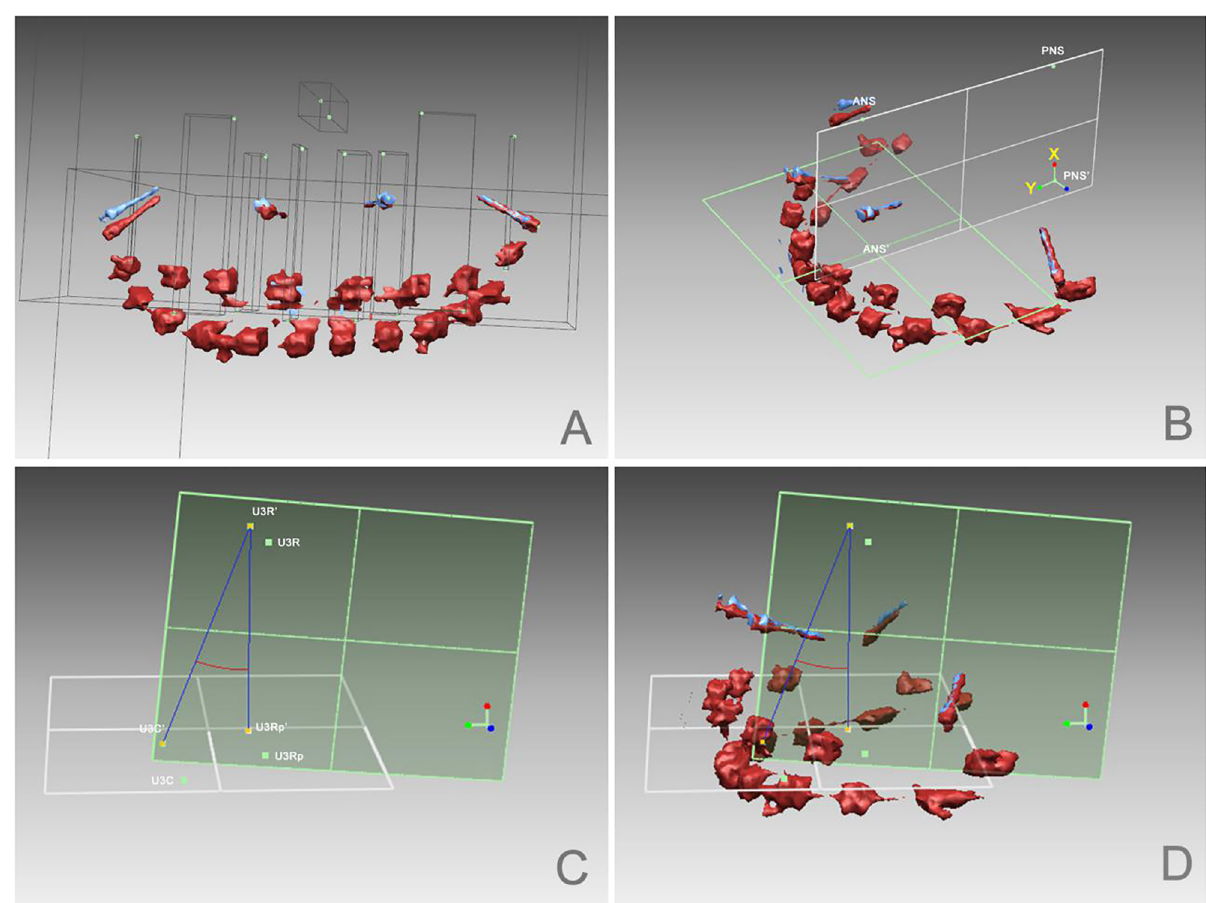
Fig 4. Analysis of 3D STL models performed using the Rapidform software. A. Landmarks were defined as follows: U6C, mesiobuccal crown cusp of the maxillary first molar; U6R, mesiobuccal root tip of the maxillary first molar; U3C, crown cusp of the maxillary canine; U3R, root tip of the maxillary canine; U2C, midpoint of the lateral incisor edge; U2R, root tip of the maxillary lateral incisor; U1C, midpoint of the central incisor edge; U1R, root tip of the maxillary central incisor; ANS, anterior nasal spine on model T2; and PNS, posterior nasal spine on model T2. B. A fitting transverse plane (plane 1) was built with points U6C and U1C on two sides of the T2 model; ANS-PNS-PNS’-ANS’ was defined as the sagittal plane (plane 2). C. U3Rp was the projection of U3R on plane 1, and U3C’, U3R’, and U3Rp’ were projections of U3C, U3R, and U3Rp on plane 2. D. Angle U3C’ U3R’ U3Rp’ was the sagittal angle of the